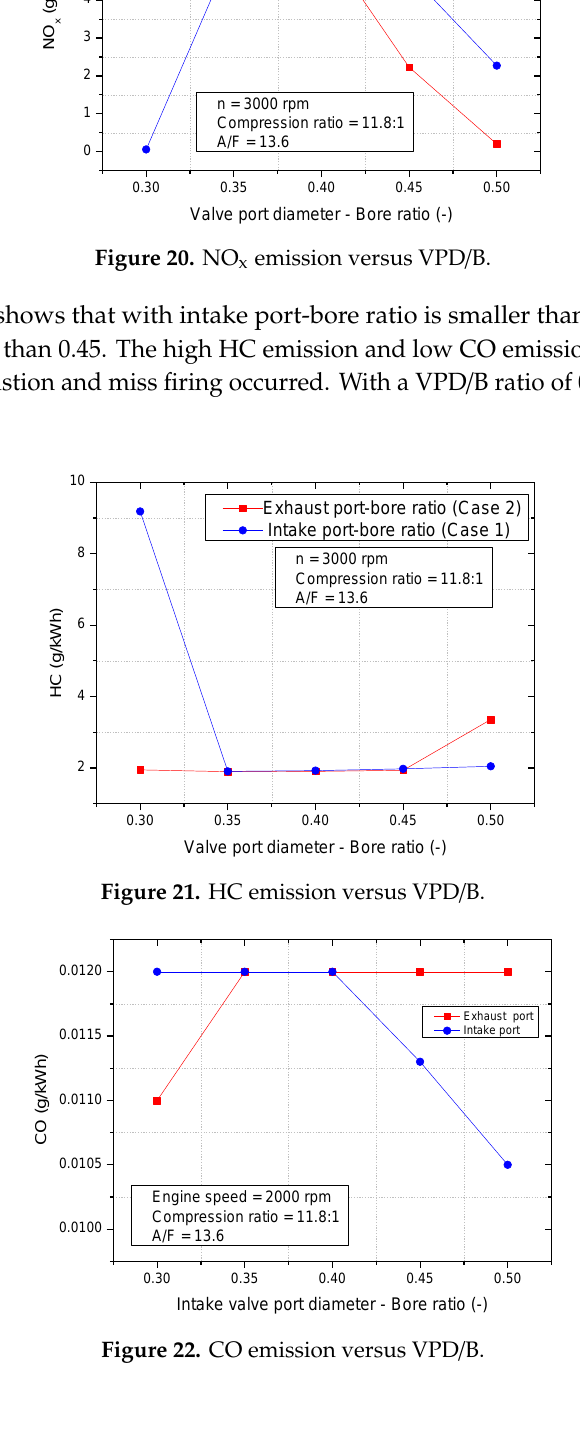
Figure 22. CO emission versus VPD/B.